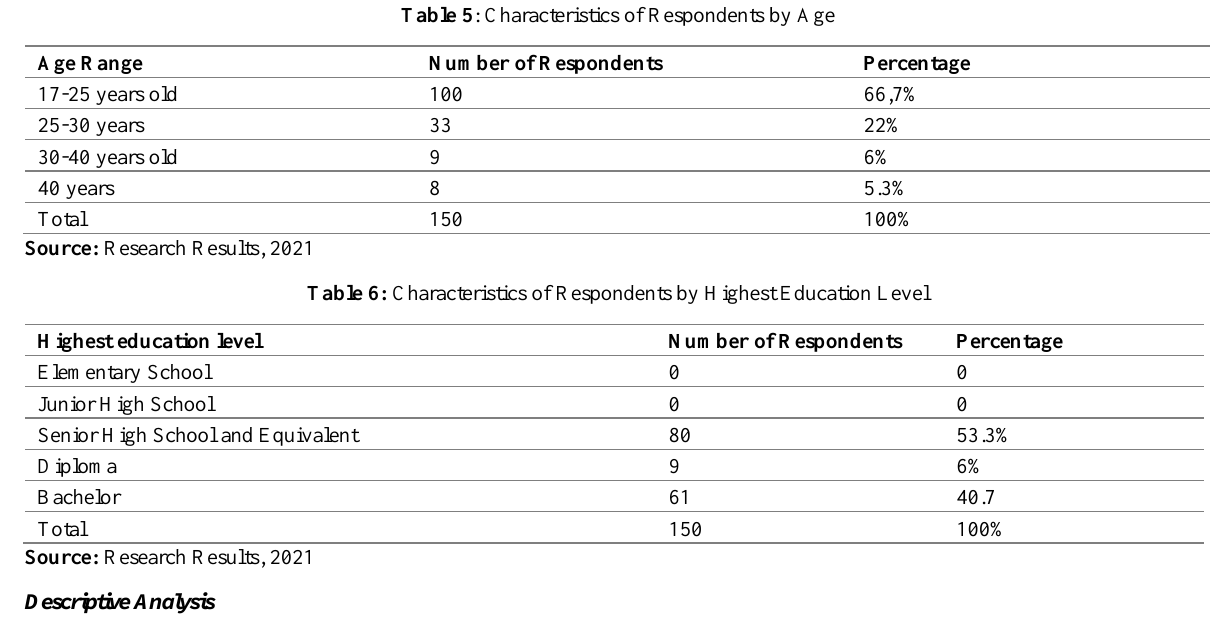
Table 7: Descriptive Statistics of Research